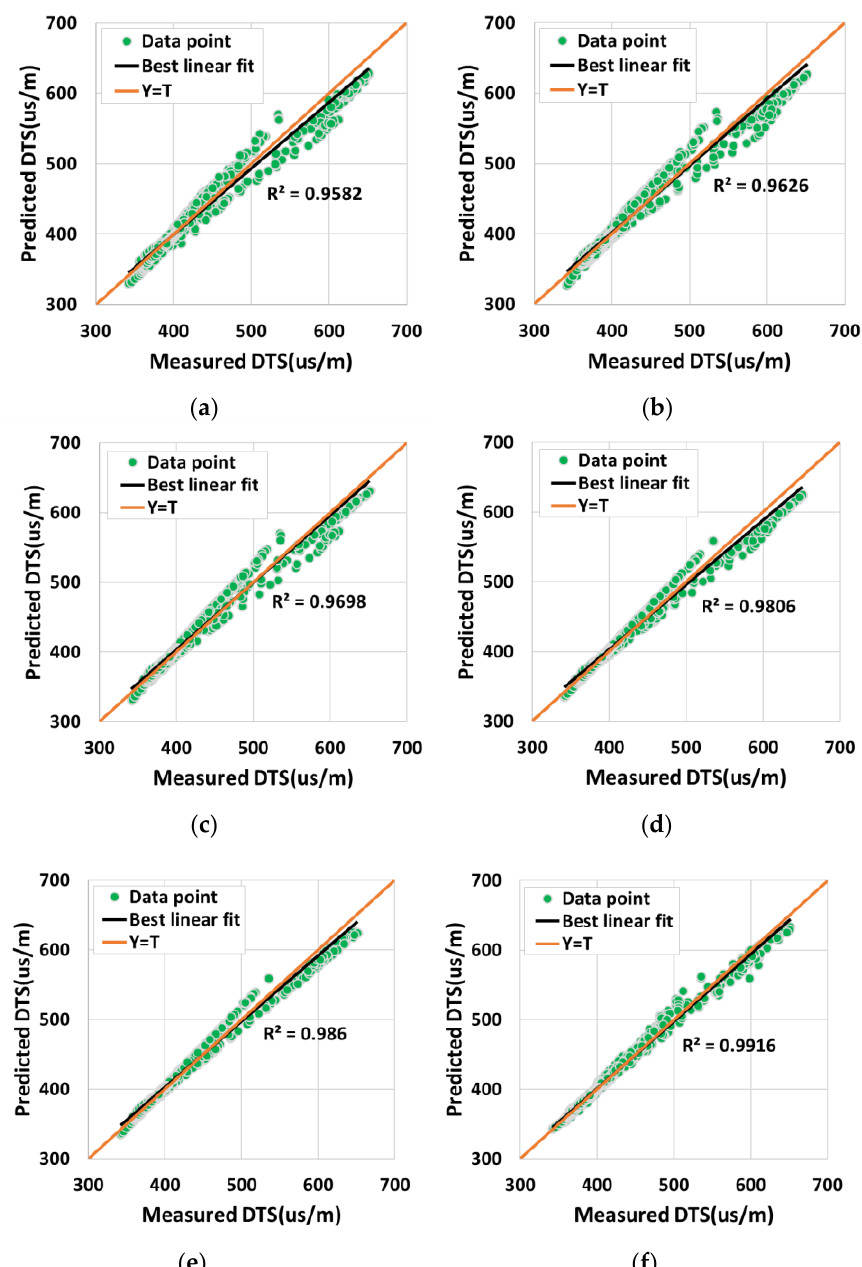
Figure 9. The comparison between the measured and anticipated DTS during the testing phases in Well N predicted by the proposed models. ( a ) ELM, ( b ) DELM, ( c ) GA-DELM, ( d ) PSO-DELM, ( e ) SSA-DELM, ( f ) ISSA-DELM.